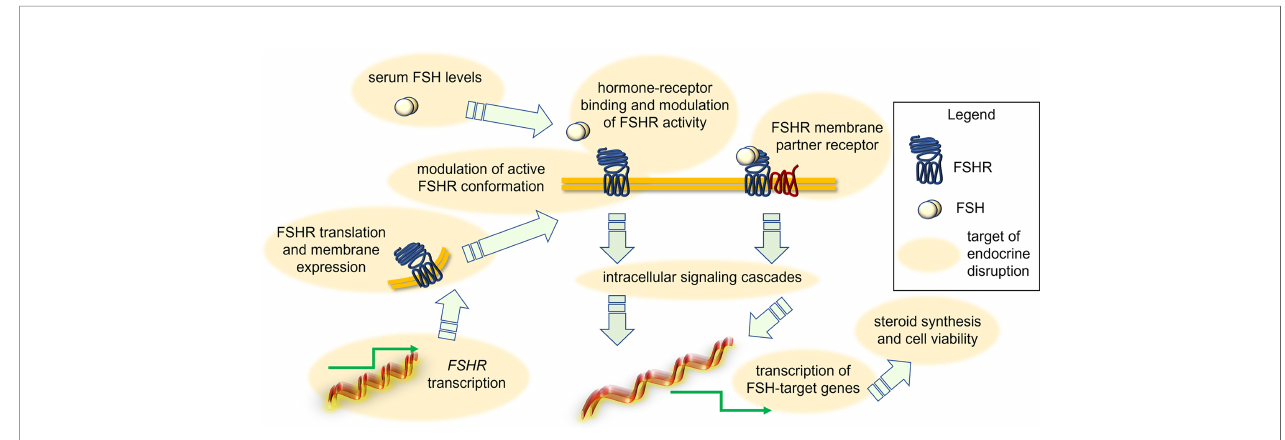
FIGURE 2 | Action of EDs in disrupting FSH-dependent endocrine signals in the ovary. Depending on the type of EDs, the FSH signal may be modulated due to changes of FSH levels, FSHR expression and attenuation of active conformation, perturbation of interaction with membrane GPCR partners, intracellular signaling cascades and target gene expression, synthesis of steroids and granulosa cell